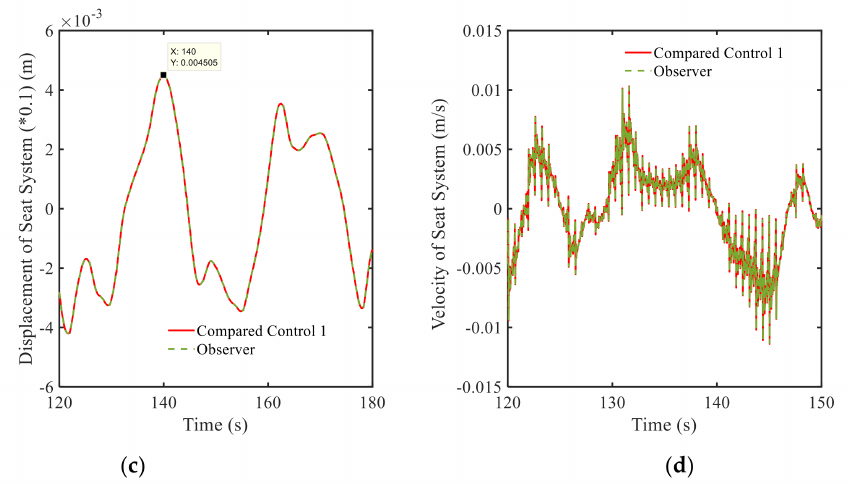
Figure 5. Displacement and velocity of the seat system of the Compared Controller 1: ( a , b ) general view, ( c , d ) enlarged view.